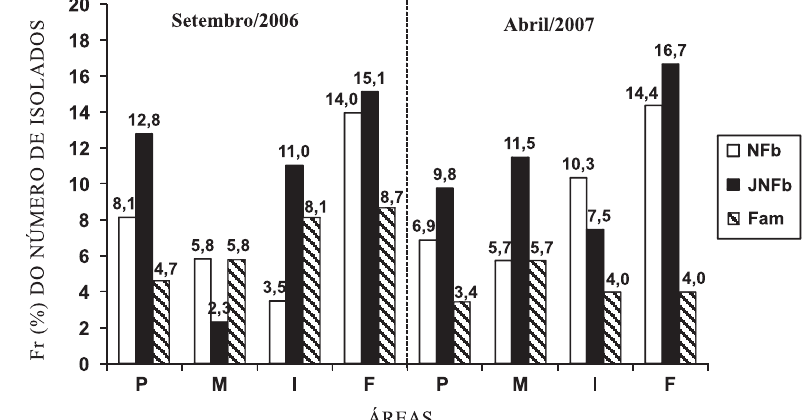
Figura 1. Frequência relativa (Fr) do número de isolados de bactérias diazotróficas não simbióticas obtidos em amostras de solo nas diferentes áreas de estudo P (plana), M (mediana), I (inclinada) e F (fora da reserva), por época de amostragem (setembro/2006 e abril/2007), utilizando meios de cultura específicos para Azospirillum spp. (NFb), Herbaspirillum spp. (JNFb) e Azospirillum amazonense